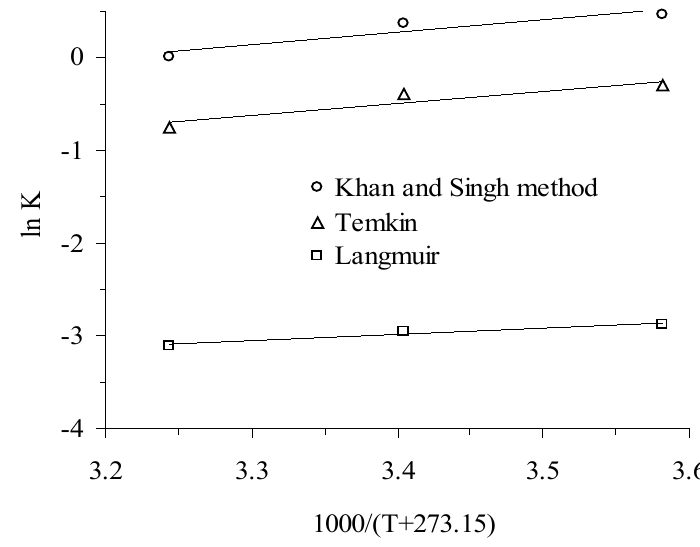
Figure 4. Plot of ln K vs . (1/T) for estimation of thermodynamic